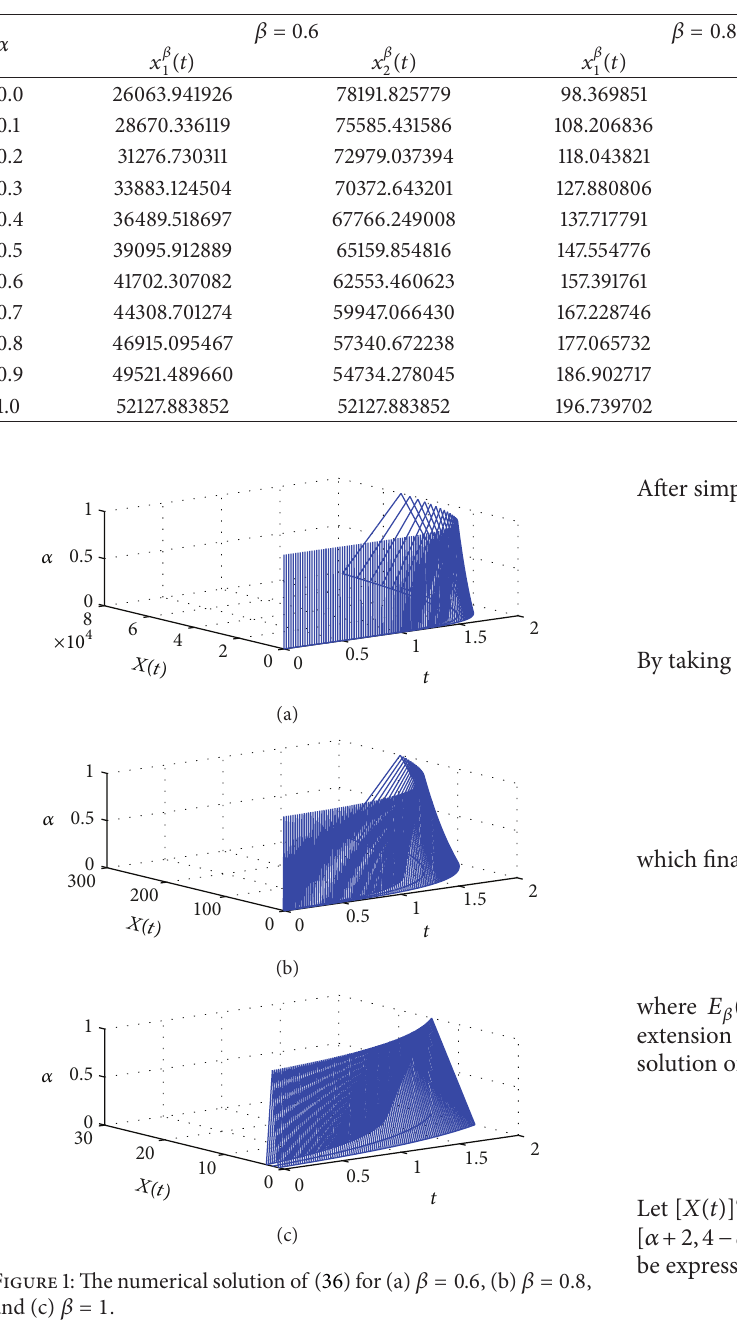
Table 1: Numerical solutions of Example 1 with different values of 𝛽 .